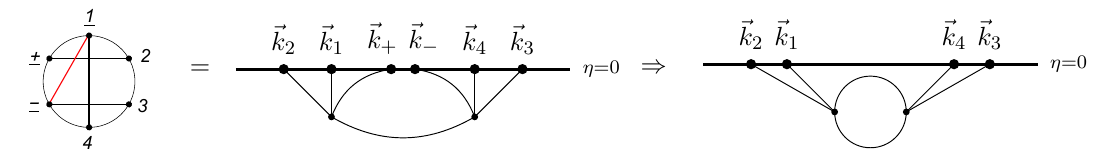
Figure 19 . Evaluating the worldsheet formula for the perfect matching on the left gives the tree-level 6-point Witten diagram in the middle. Pasting together the ± legs using the procedure described in the text then gives the 1-loop 4-point Witten diagram on the